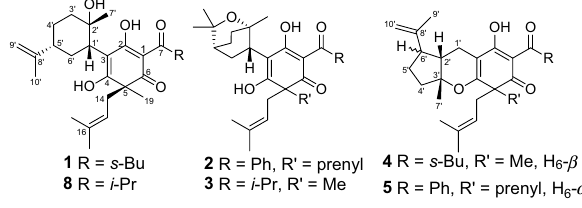
Fig. 1 Structures of compounds 1 – 5